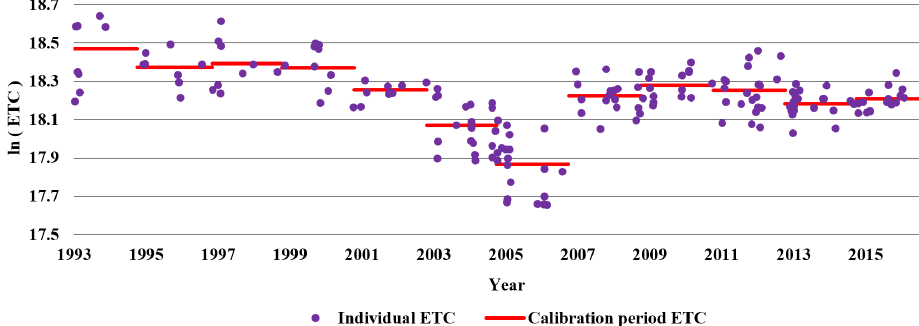
Figure 4. Time series of ETC values for the wavelength of 320nm during 12 intercalibration periods, 18 August 1993–13 May